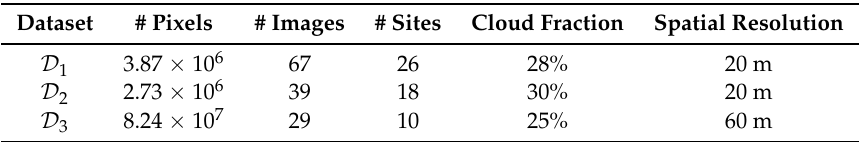
Table 2. Overview of the data used in this work: D 1 training, D 2 homogeneous test, D 3 inhomogeneous test. Dataset # Pixels # Images # Sites Cloud Fraction Spatial